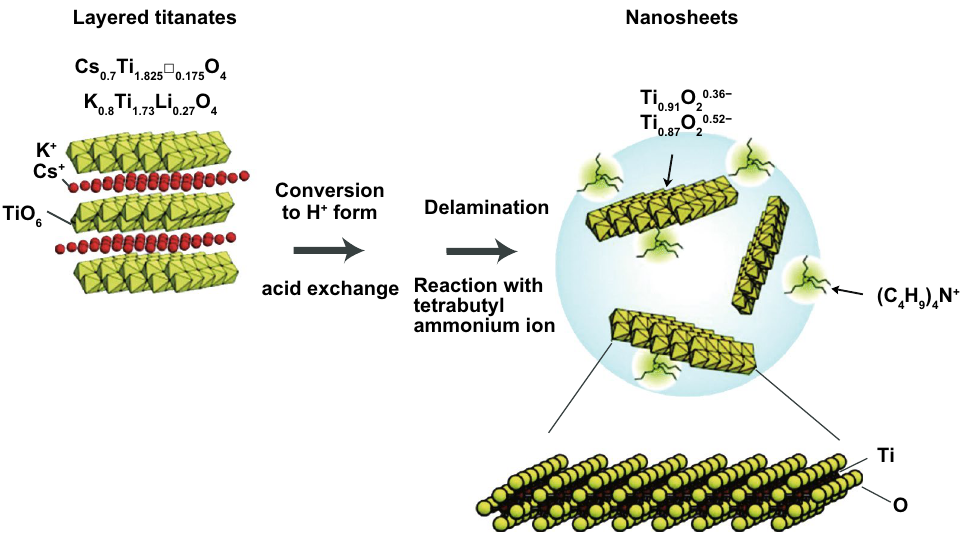
Fig. 4 Scheme showing the crystal structure of lepidocrocite kind titanate and its exfoliation into TiO 2 NSs. Adapted with permission from Ref.